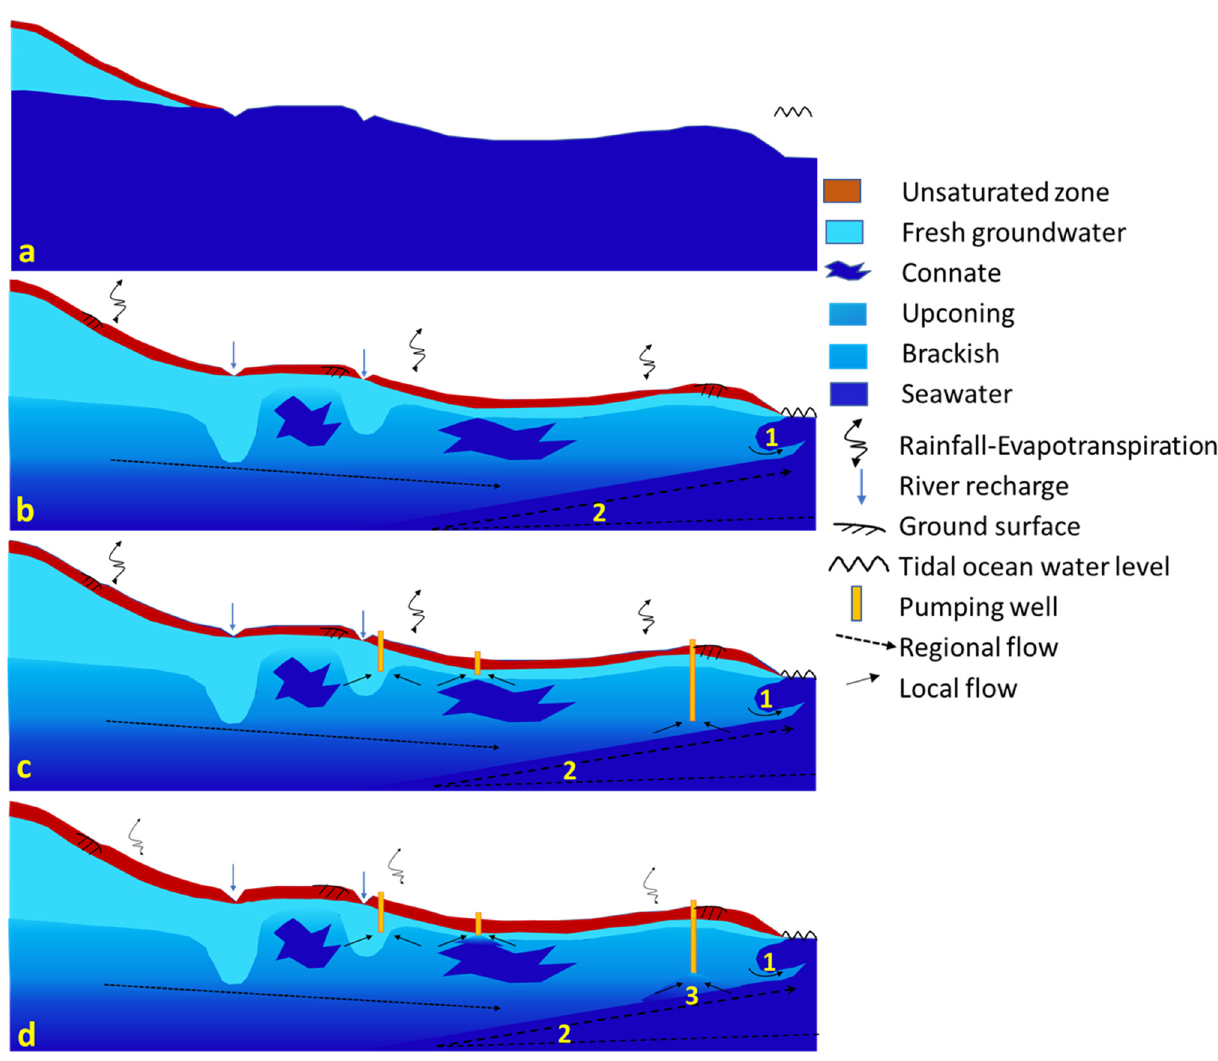
Figure 15. Simplified diagrams of the coastal aquifer in the Luy river catchment: 1—coastal fringe processes, such as tidal seepage face and upper seawater recirculation zone, 2—density driven circulation in the seawater zone, 3—seawater upconing due to well pumping. The saltwater intrusion and freshening processes in the different time: ( a ) Seawater covered the catchment during the past transgression, ( b ) natural freshening, ( c , d ) freshening and saltwater intrusion affected by human activities during rainy and dry seasons, respectively.